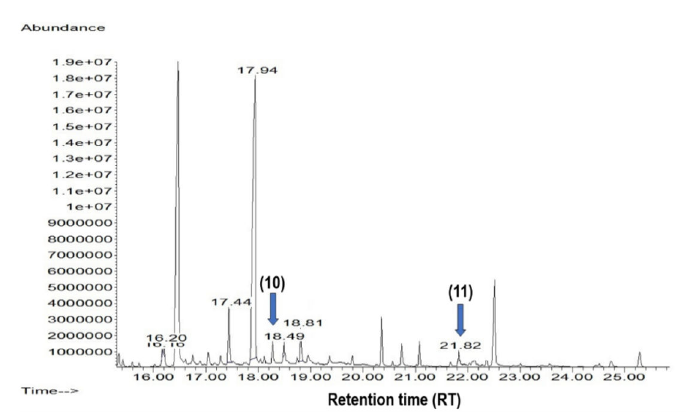
Figure 6. Gas chromatography coupled with mass spectrometry (GC-MS) chromatogram of the ethyl acetate extract from day 8 of the suspension cell cultures, showing the encecalin (10) and 3,5-diprenyl-4-hydroxyacetophenone (11) compounds.